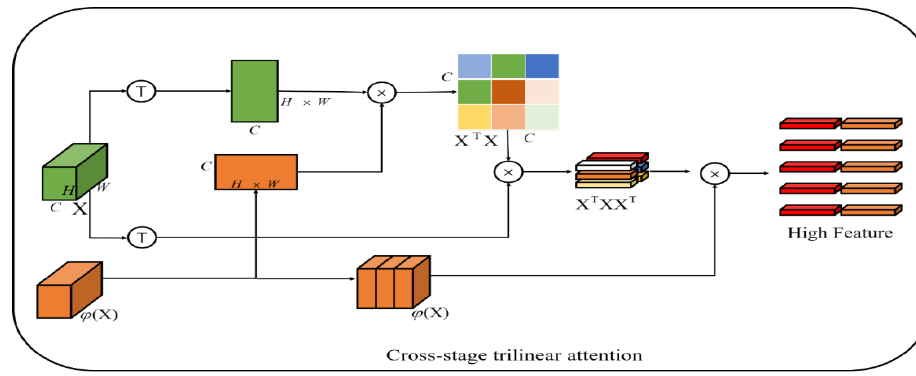
Figure 3. Cross - stage three - linear attention fine - grained feature learning module (CTA). Figure 3. Cross‑stage three‑linear attention fine‑grained feature learning module (CTA). Therefore, a common method is to use bilinear spatial attention. The second‑order matrix F a of each position ( i , j ) is classified by merging itself X A ∈ R WH × C CNN stream X B ∈ R WH B , and then the final feature is used in the final category through a fully connected (fc)